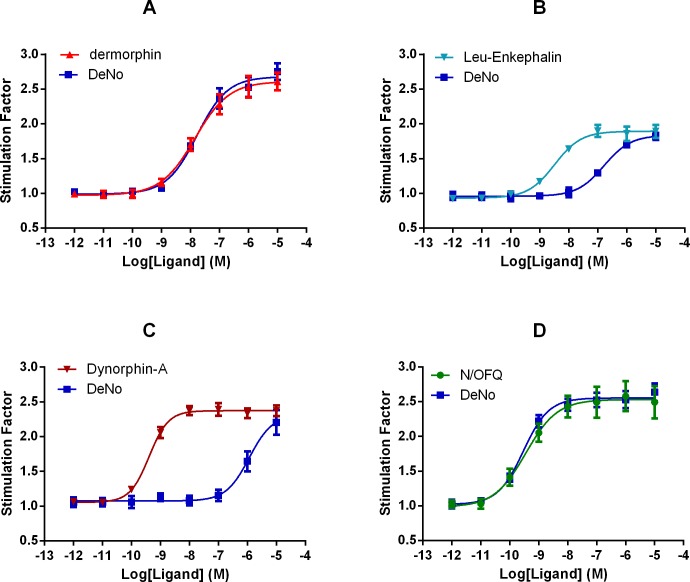
GTPγ[35S] Response Curves.Ligand stimulated GTPγ[35S] binding by DeNo and reference ligands are shown at A) CHOhMu, (B) CHOhDelta, (C) CHOhKappa and (D) CHONOP cell membranes. Graphs are represented as a stimulation factor, which is the fold change in activity when compared to basal. Data are mean (±SEM) for n = 5 experiments.